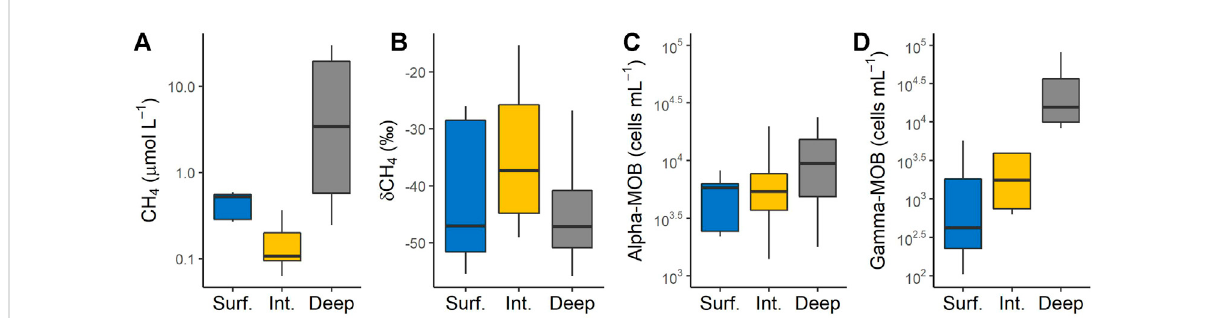
Variability of methane (CH 4 ) concentration (A) , stable carbon isotopic signature of CH 4 ( δ 13 C-CH 4 ) (B) , abundance of α (C) and γ (D) groups of methanotrophicbacteria( α -MOBand γ -MOB,respectively)atthestartoftheincubationexperimentsacrossallstudylakes.Surf.,Surfacelayer;Inter., Intermediate layer; Deep, Deeper layer. The boxplots represent the median, fi rst and third quartiles (hinges) and the 1.5 × interquartile range (whiskers).